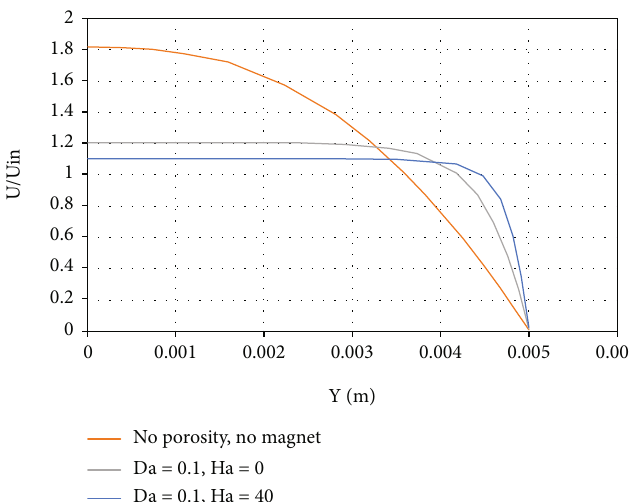
Figure 7: Dimensional dimensionless velocity versus radius of the cylinder for di ff erent inclination angles using water as base fl uid.